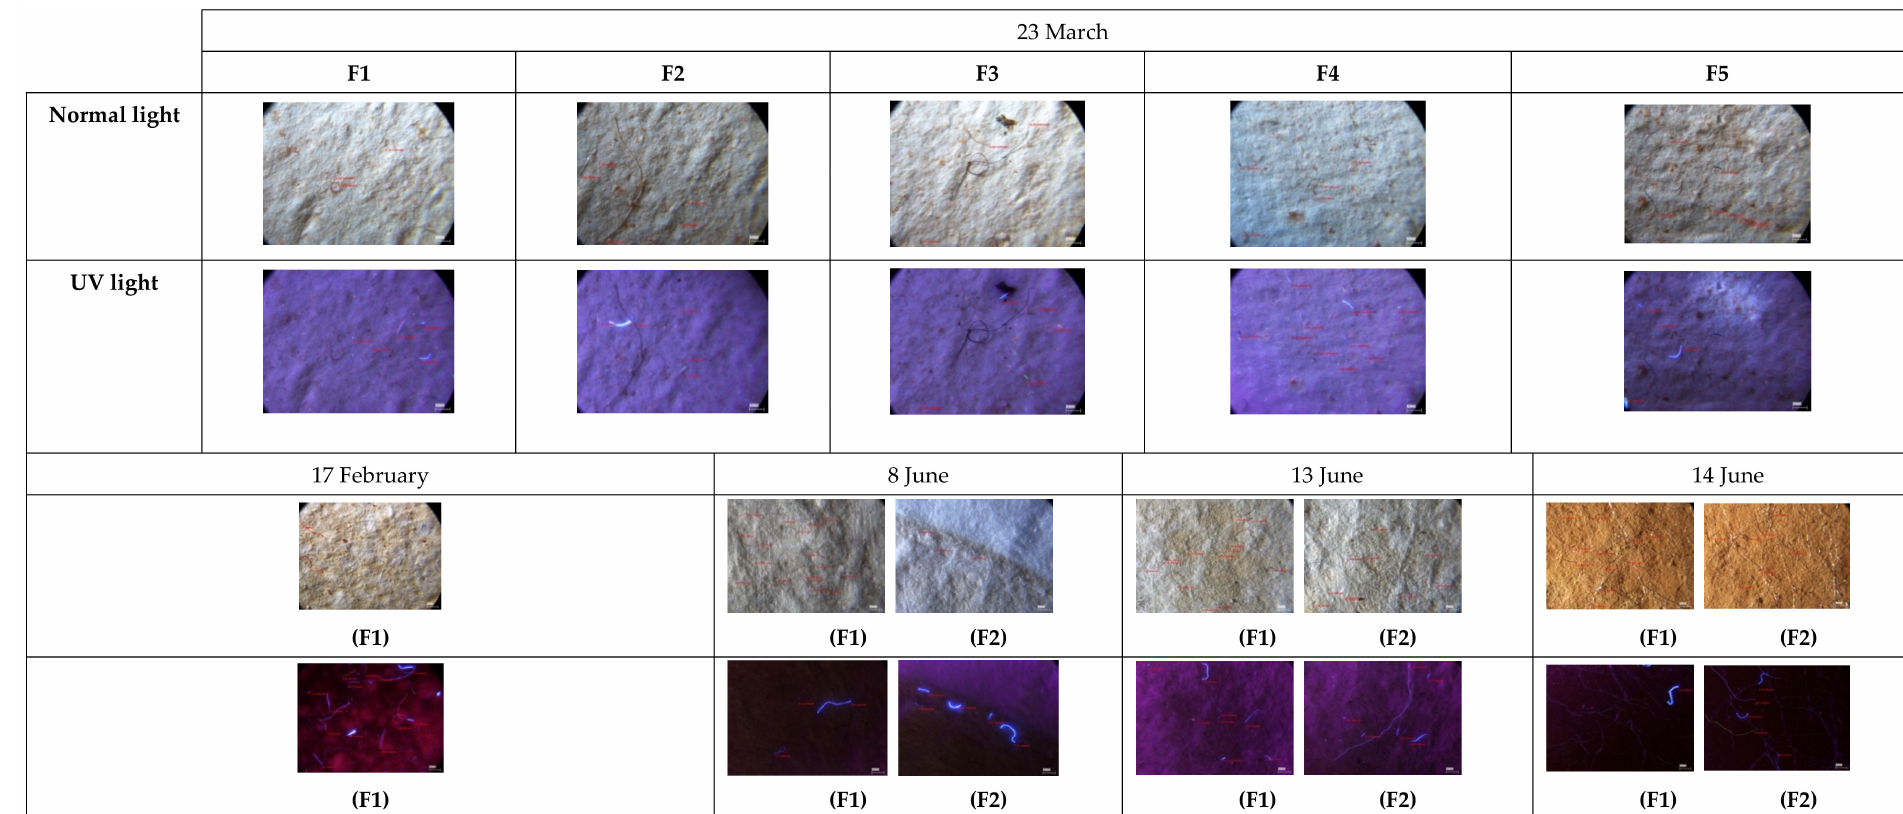
Figure 2. Microscopic images (normal and UV light) of the filters deriving from the outflow